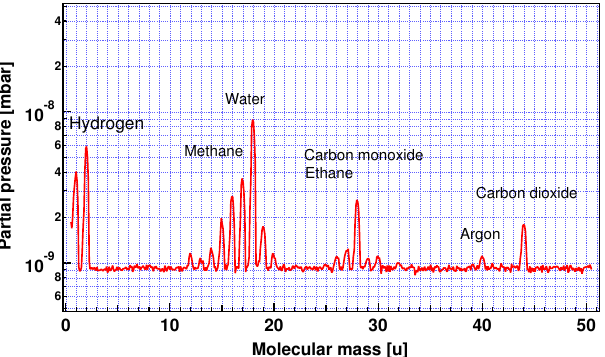
Figure 12. Typical residual gas mass spectrum during data taking, measured in the large output chamber. The main residual gases (from left to right ) are hydrogen, methane, water vapor, carbon monoxide, and carbon dioxide. The absence of the oxygen peak indicates the absence of nitrogen. All gas pressures were well below the VMB equivalent pressures reported in Table 1 on page 15.